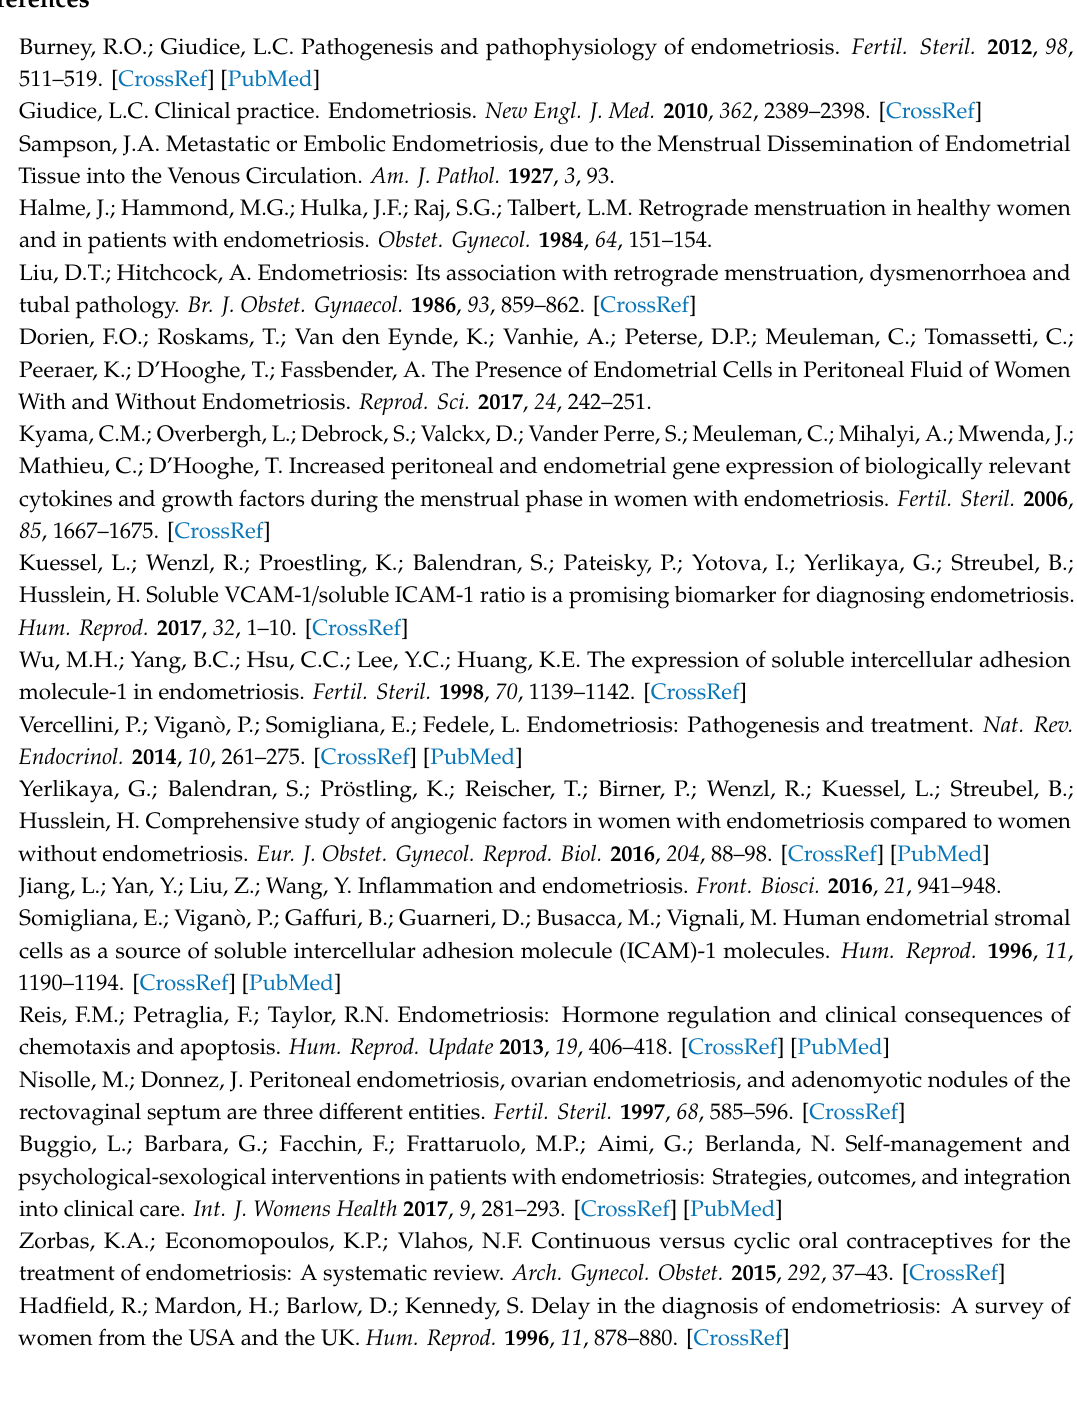
Table S1: List of all proteins included in the Proseek ® Multiplex Oncology I v2 96 × 96 Cancer